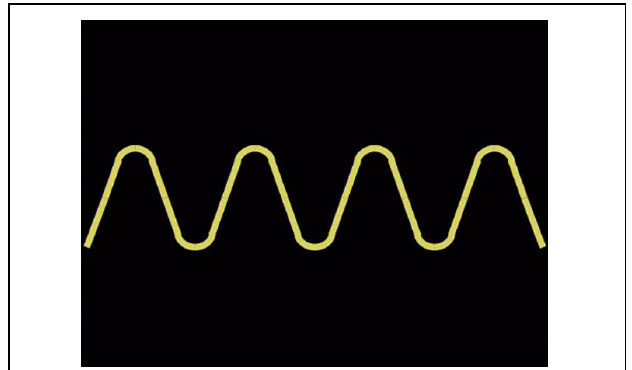
FIGURE 1 | Example of Foresight figure used to elicit responses from subjects. Subjects are asked to describe what the figure “makes you think of, looks like, reminds you of, or suggests to